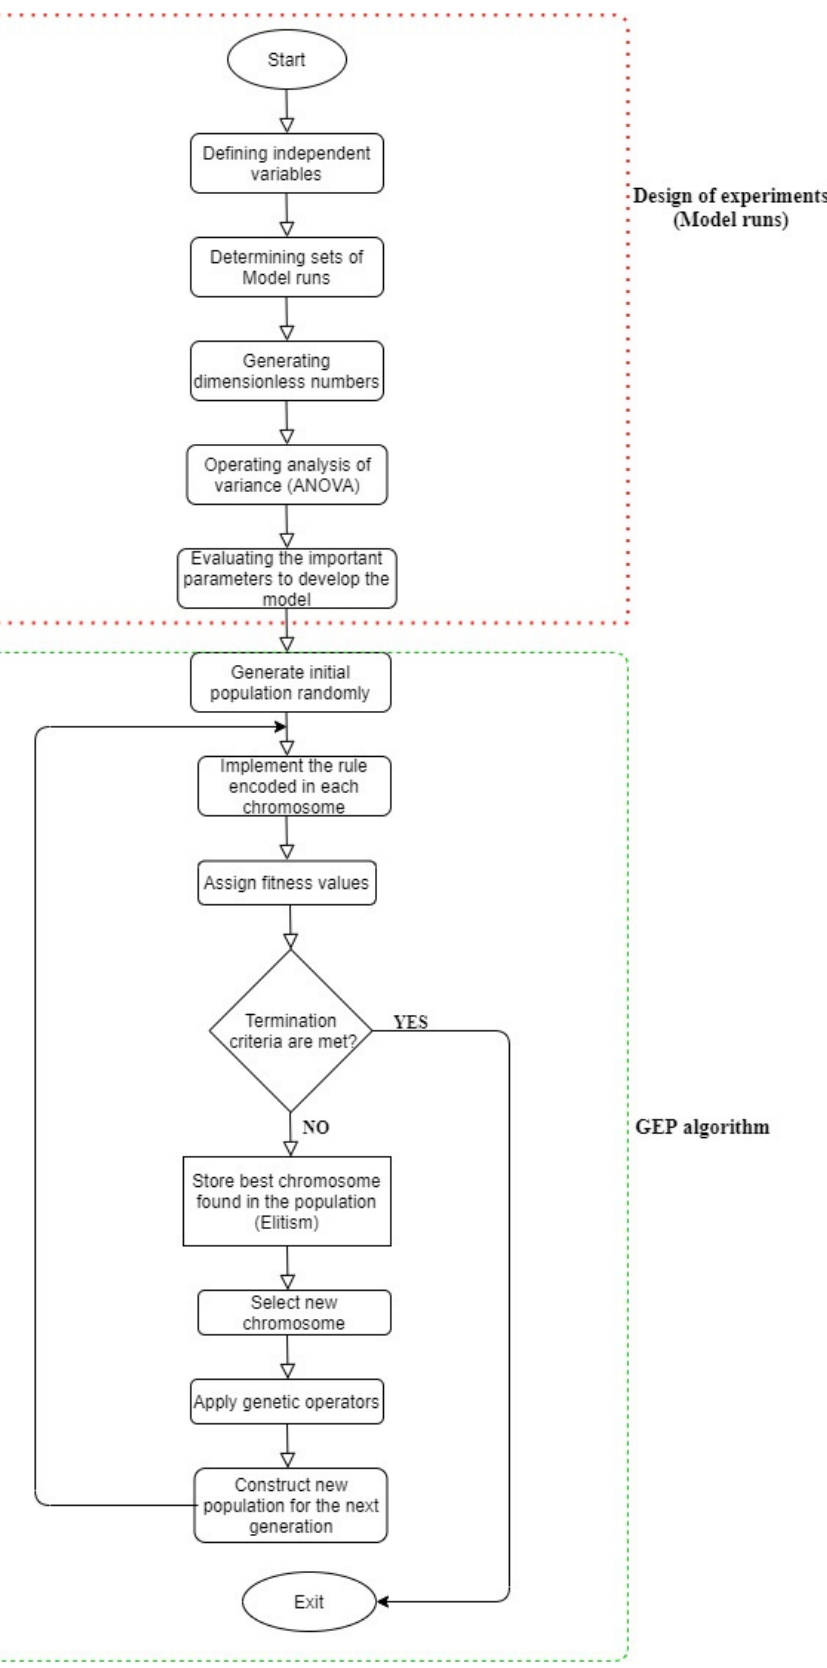
Figure 3. A schematic flowchart of workflow for developing the RF correlation of WAG in this research.